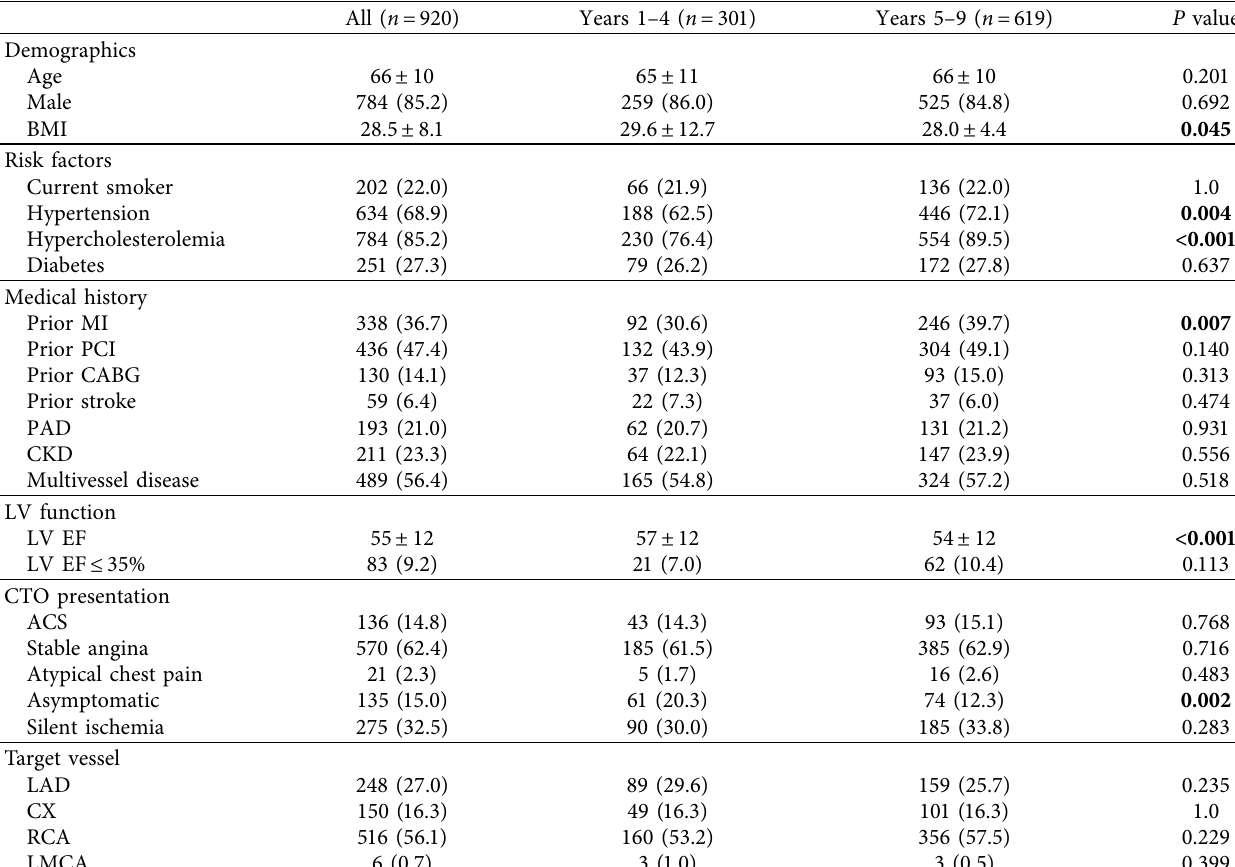
Table 1: Baseline patient